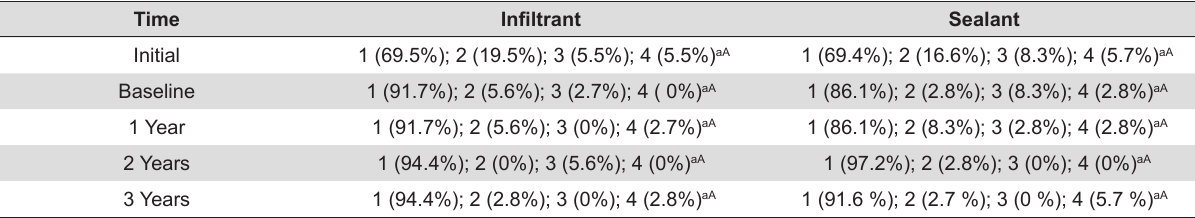
Table 1- Percentual distribution (%) of caries detection using laser fluorescence